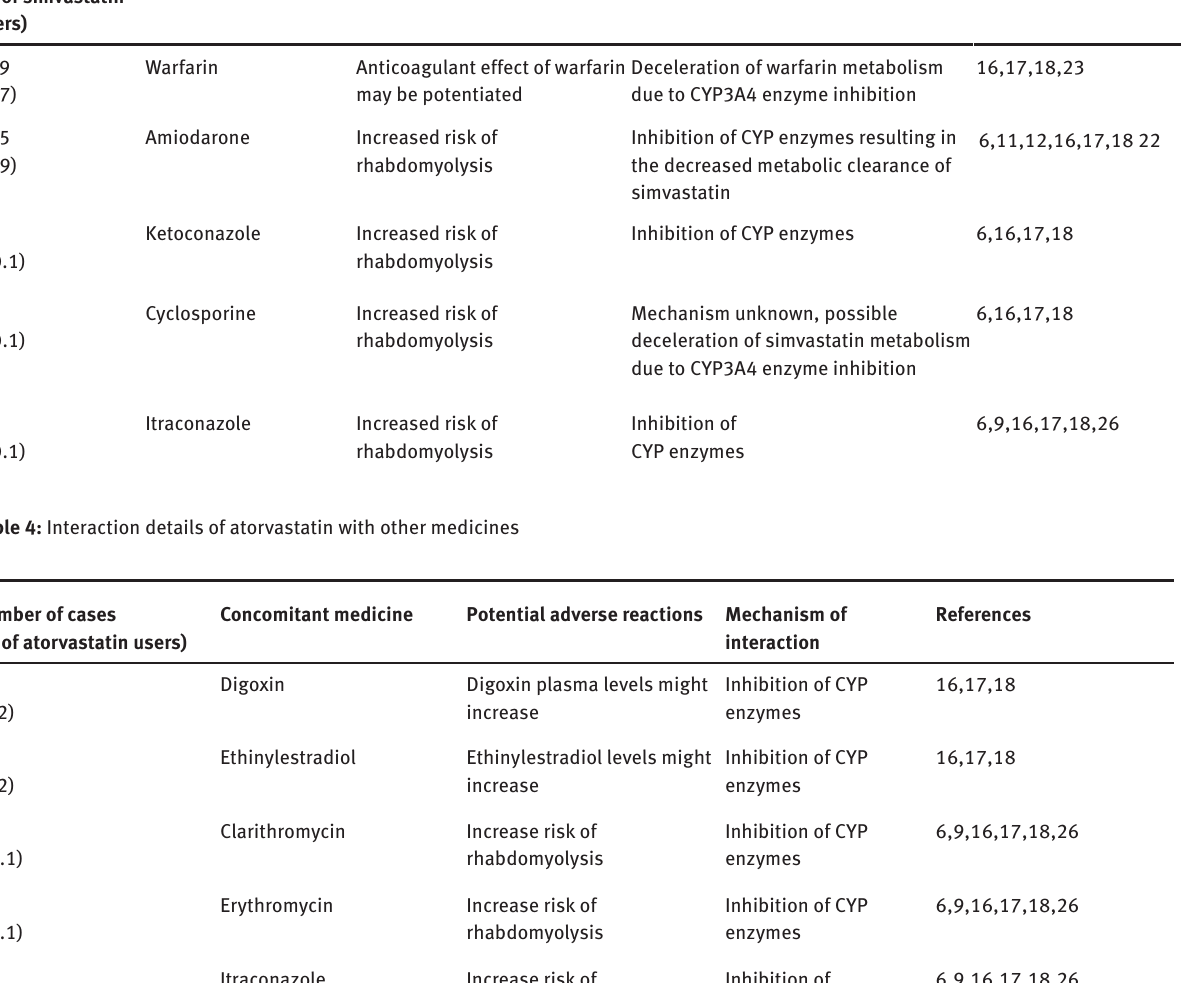
Number of cases